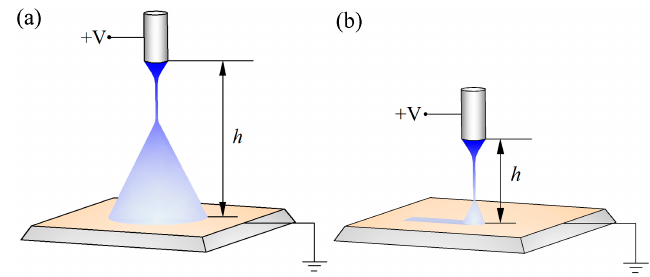
Figure 1. The diagram sketches of electrospray. ( a ) Conventional electrospray; ( b ) near-field electrospray.